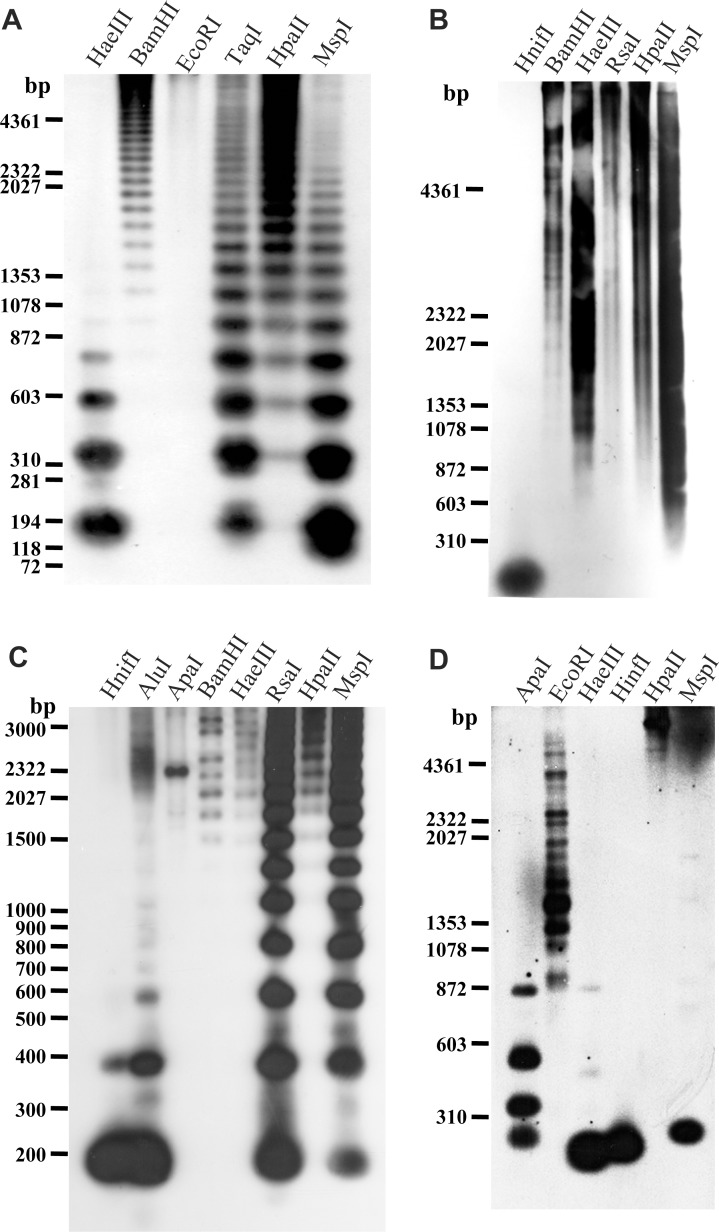
Southern blot hybridization patterns of four repetitive sequence families.Southern blot hybridization of A. platyrhynchos genomic DNA probed with the APL-HaeIII-04 fragment (A). Southern blot hybridization of A. fabalis genomic DNA probed with the AFA-HinfI-S03 (B) and AFA-HinfI-L04 (C) fragments. Southern blot hybridization of C. cygnus genomic DNA probed with the CCY-ApaI-05 fragment (D). A mixture of λ DNA–HindIII and ϕX174 DNA–HaeIII was used as a molecular size marker for (A, B, D), and a mixture of λ DNA–HindIII digest and 100-bp ladder digest was used for (C).